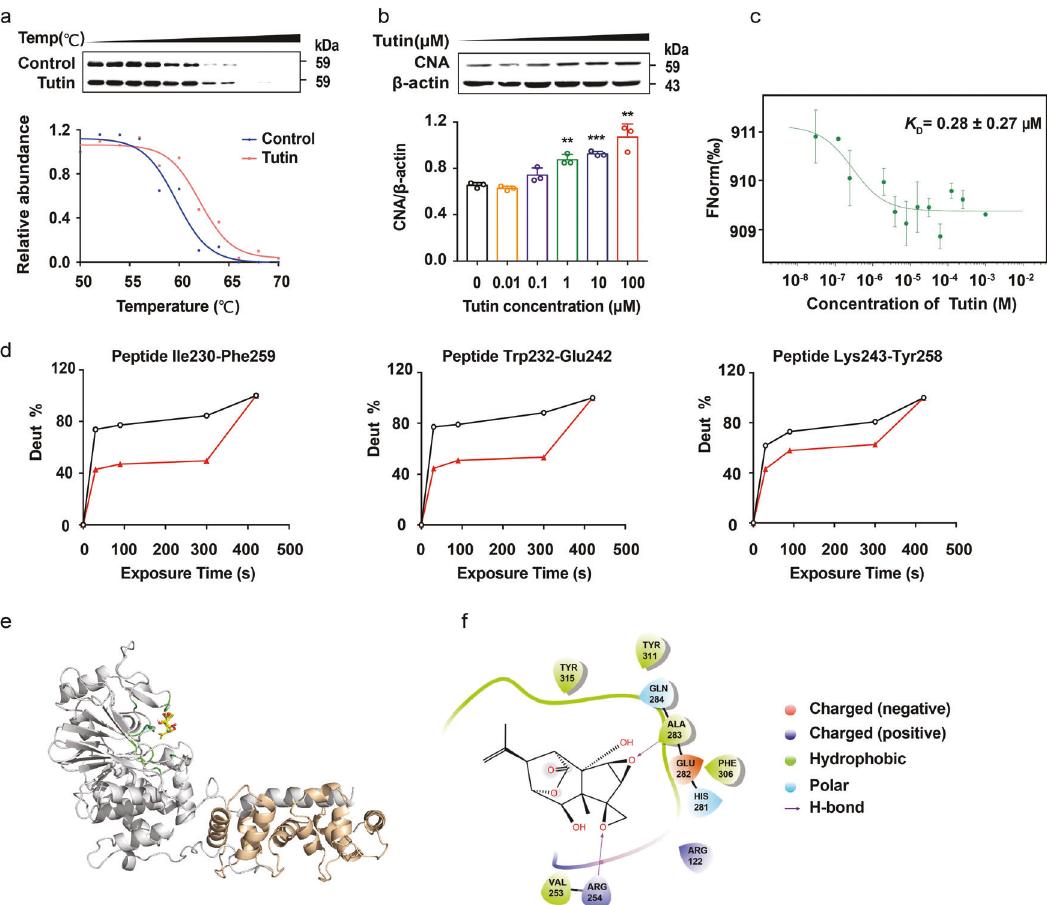
response curve shows the interaction between tutin and CN. Results were expressed as mean ± SD with n = 3. d Deuterium uptake of peptides targeted by tutin. HDX graphs of CN alone (black curves) and bound both to tutin (red curves). e Structural overview of a predicted CN-tutin complex model (CNA: gray, CNB: orange, tutin: yellow, residues: green). Zoom-in view of the predicted CN-tutin interface. f Interface residues (Arg 254 and Ala 283) in CN are shown and labeled by the names and positions of